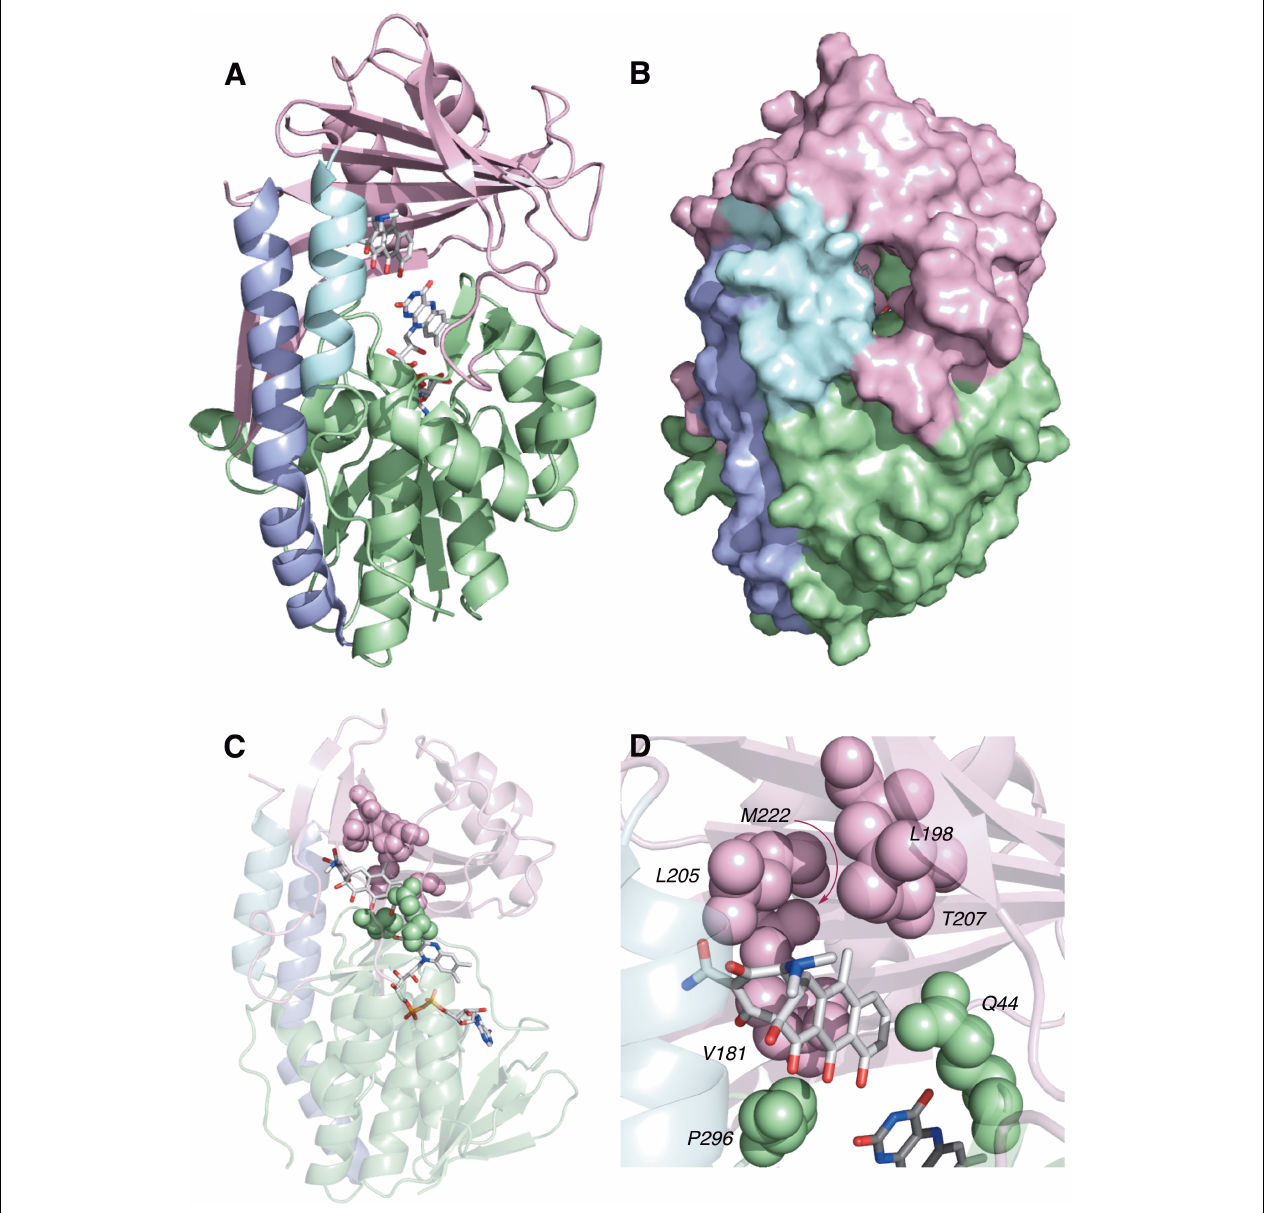
FIGURE 12 | (A) X-ray crystal structure of anhydrotetracycline bound to Tet50 in Mode I A , D (PDB accession number 5tuf). (B) Surface view of X-ray crystal structure of aTC bound to Tet50. (C) X-ray crystal structure of anhydrotetracycline bound to Tet50 in Mode I A , D with recognition residues highlighted. (D) Expanded X-ray crystal structure of anhydrotetracycline bound to Tet50 in Mode I A , D with recognition residues highlighted and labeled. Images were generated using PyMOL